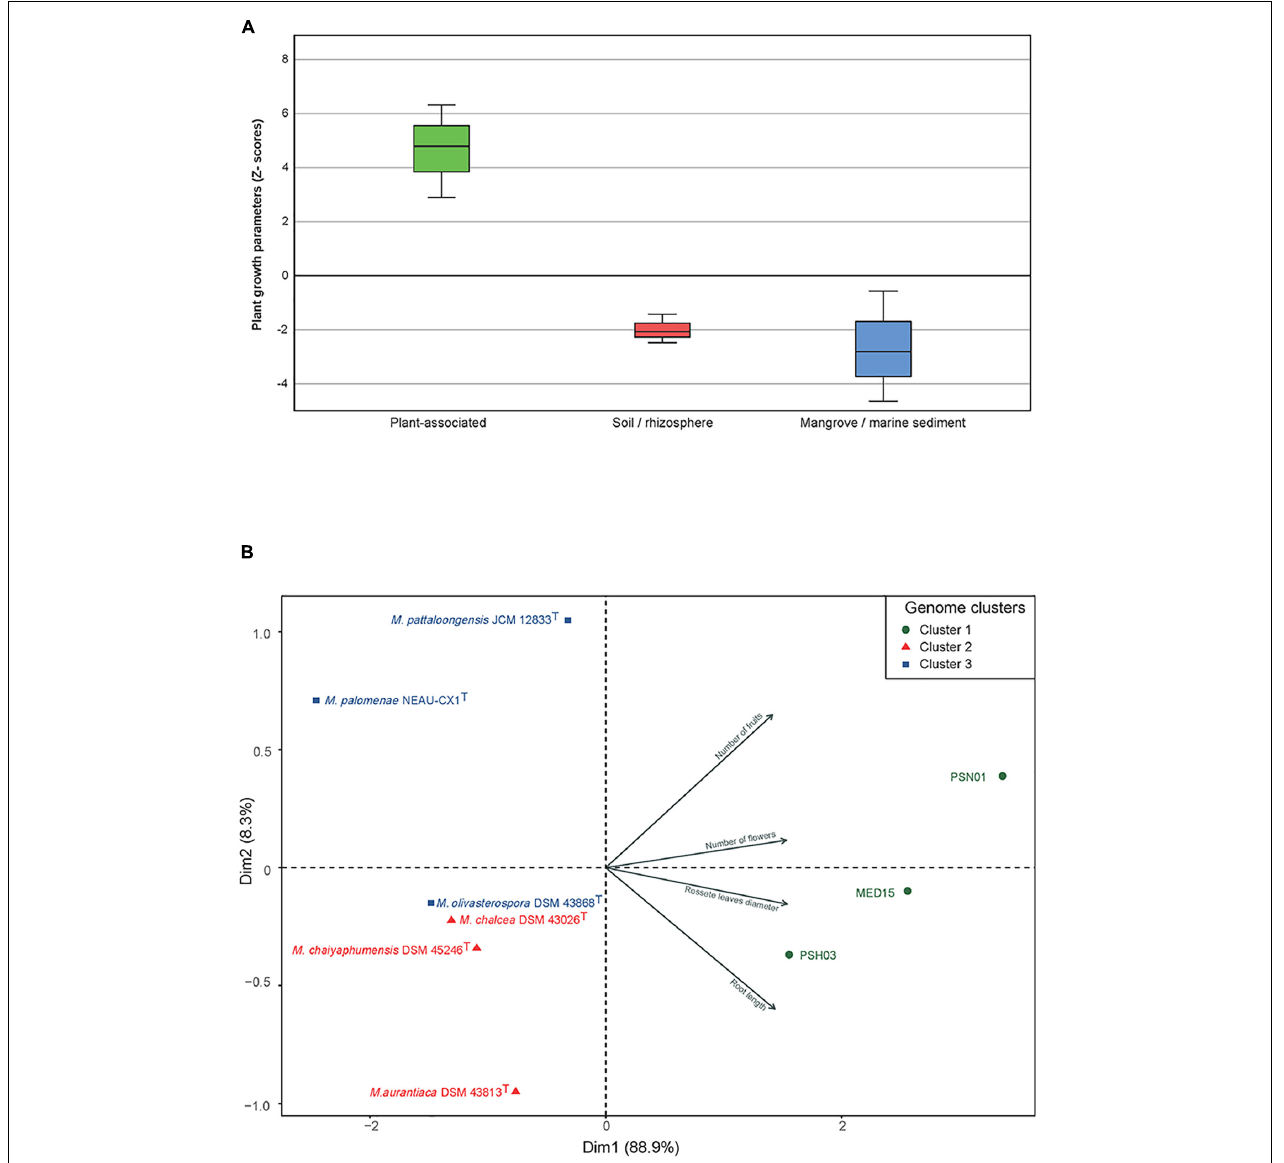
FIGURE 6 | (A) Accumulated Z-scores of the growth parameters measured in A. thaliana after 4 weeks of growth and inoculated with Micromonospora strains selected from clusters C1, C2, and C3. (B) PCA distribution of the strains based on the plant growth parameters measured. Symbols: green circles, C1 (plant-associated); red triangles, C22 (soil/rhizosphere); blue squares, C3 (mangrove/marine